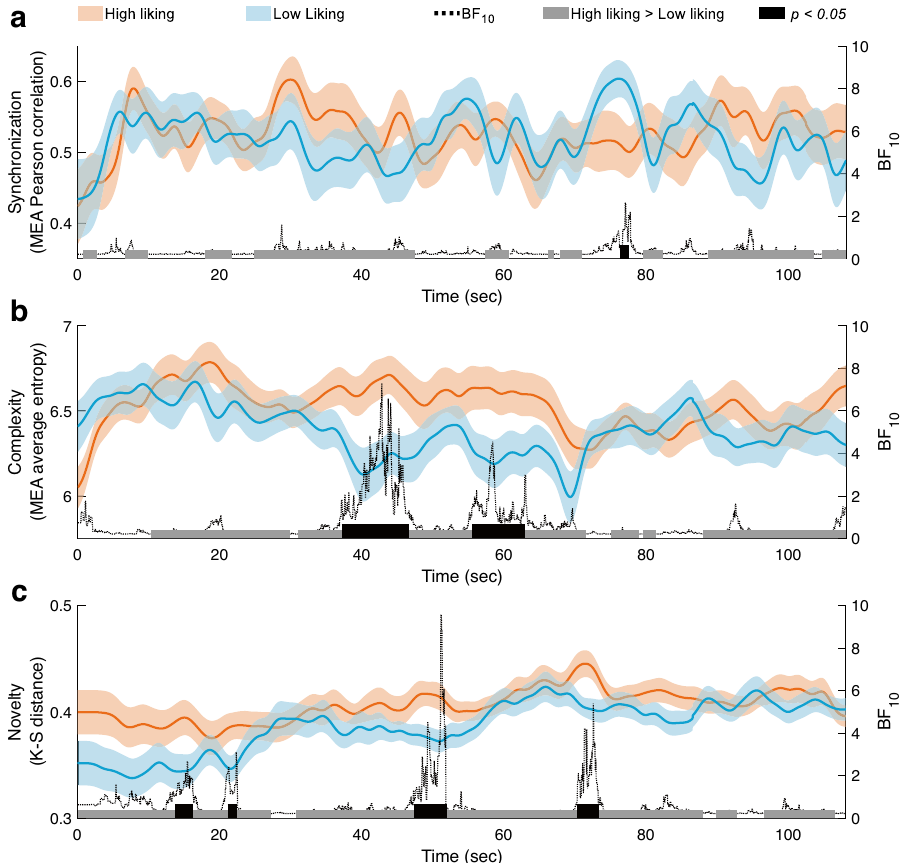
Figure 5. The dyadic movement measures along the interaction duration for high and low-liking. The orange and blue lines denote the average value of the high- and low-liking groups respectively, along the time-points of the Mirror Game. The shaded orange and blue marks denote the SE s of the high- and low-liking groups, respectively. The gray marks at the bottom of each panel denote time-points in which the high-liking group had a higher value than the low-liking group. The black marks denote time-points in which there was a significant difference between the liking groups. The black dashed lines depict two-tailed Bayes factors ( BF 10 ). ( a ) Synchronization was higher in the high-liking group than in the low-liking group for 55.87% of the game duration, binomial sign test P < 0.001. ( b ) Complexity was higher in the high-liking group than in the low-liking group for 79.62% out of the game duration, binomial sign test P < 0.001. ( c ) Novelty was higher in the high- liking group during 90.16% of the game, binomial sign test P <